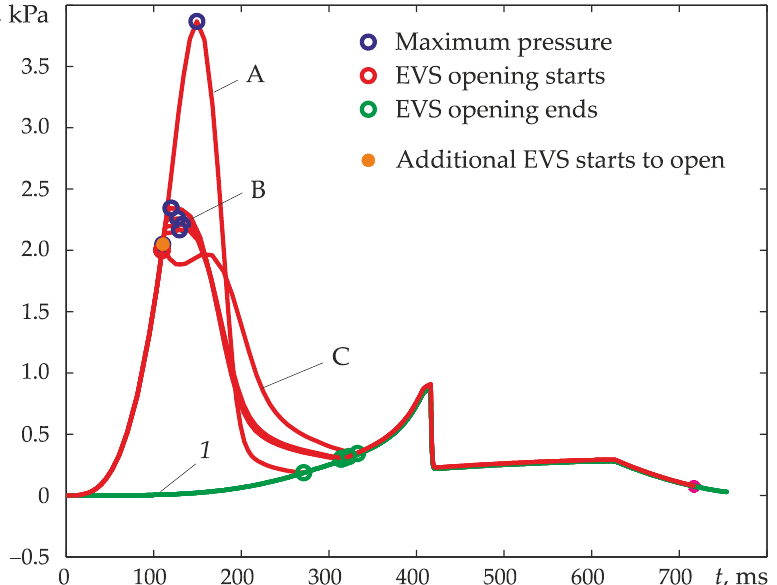
Figure 10. Excessive pressure of an explosion inside a kitchen: ( A ) non-upgraded EVS; ( B ) EVS equipped with an additional 0.25 m 2 opening covered with an EVS that opens when pressure reaches 2.05 kPa; response rates are 0.5, 0.25, 0.125, and 0.05 kPa; ( C ) opening covered with a crushable membrane (glass); 1 — explosive pressure inside the kitchen with a fully open window area.